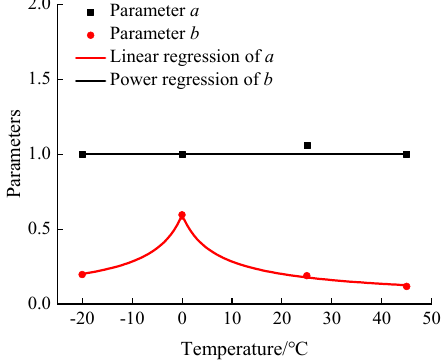
Figure 13. Relation between strain rate effect parameters and temperature.